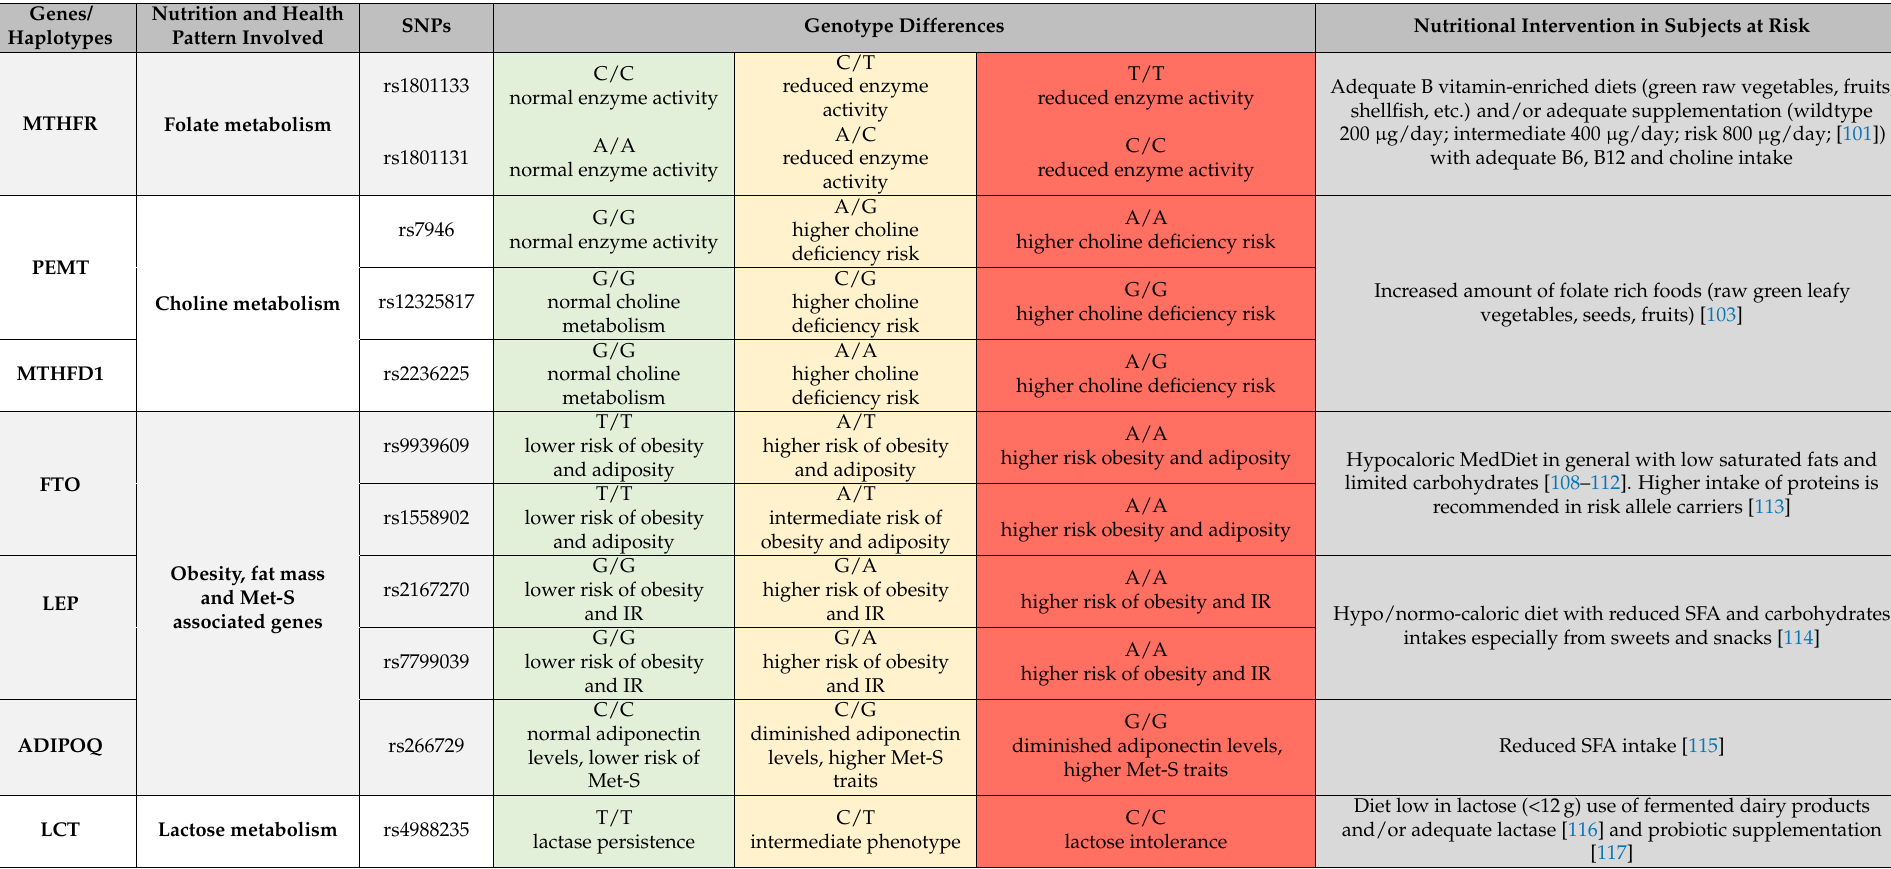
Table 1. Practical examples of single nucleotide polymorphisms (SNPs) that can influence a proinflammatory environment in infertile women and the suggested nutritional